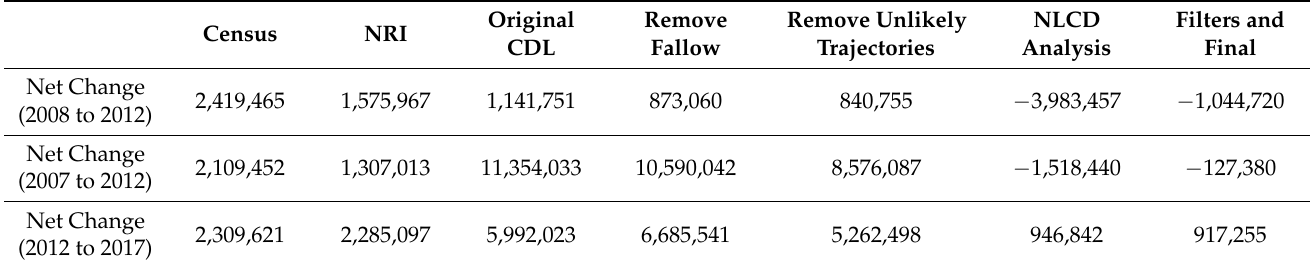
Table 3. Estimated Net Change in Cropland for the NRI, Census and CDL for different year intervals before and after the CDL has post-classification refinement techniques